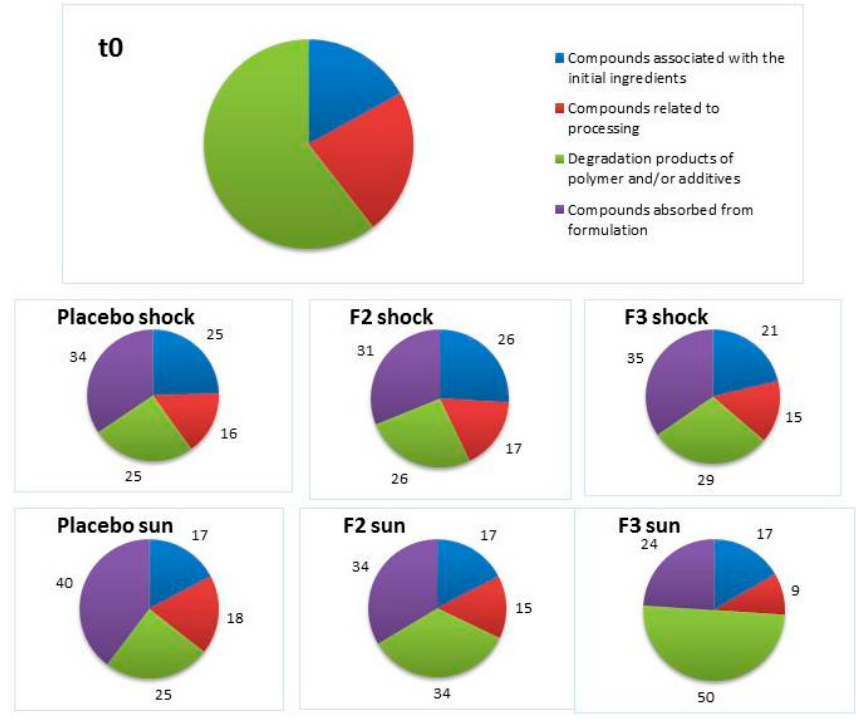
Figure 5. Percentage of areas of substances extracted from containers filled with formulations after treatments.